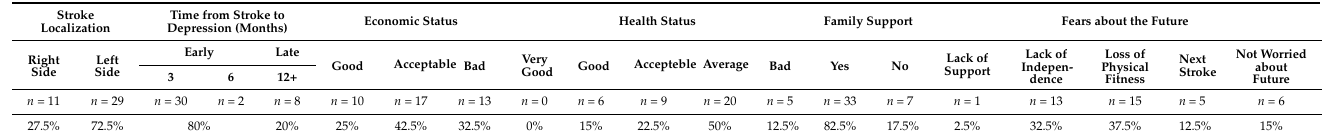
Table 1. Characteristics of patients and economic and health